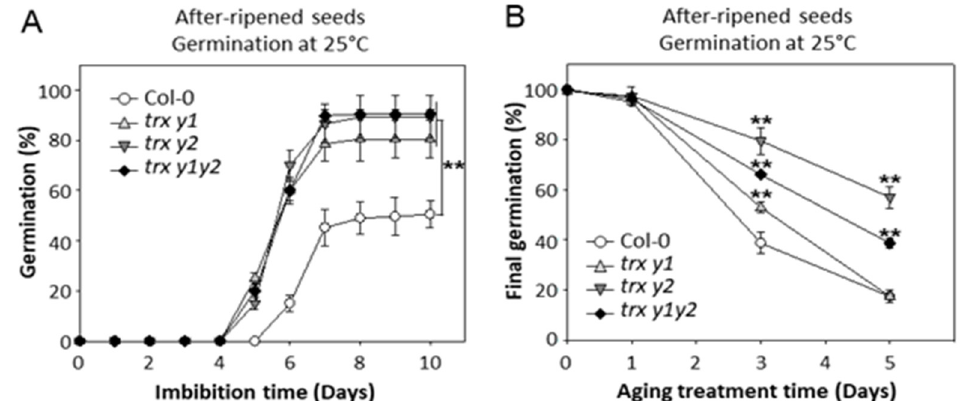
Figure 2. Germination of Trxs y mutant seeds under osmotic stress or after accelerated aging (AA). ( A ) After-ripened seeds were imbibed in the dark at 25 °C using a PEG solution ( − 0.6 MP) instead of water. ( B ) AA was performed by storing after-ripened seeds (after 12 weeks of dry storage) at 75% relative humidity for 1, 3, or 5 days at 40 °C. Then, seeds were dried back at 32% relative humidity and directly tested for germination capacity (same conditions as in Figure 1B). Means ± SD from triplicate experiments (3 independent seed batches). Significance levels: ** p < 0.01 compared to Col-0 by Student’s t -test.